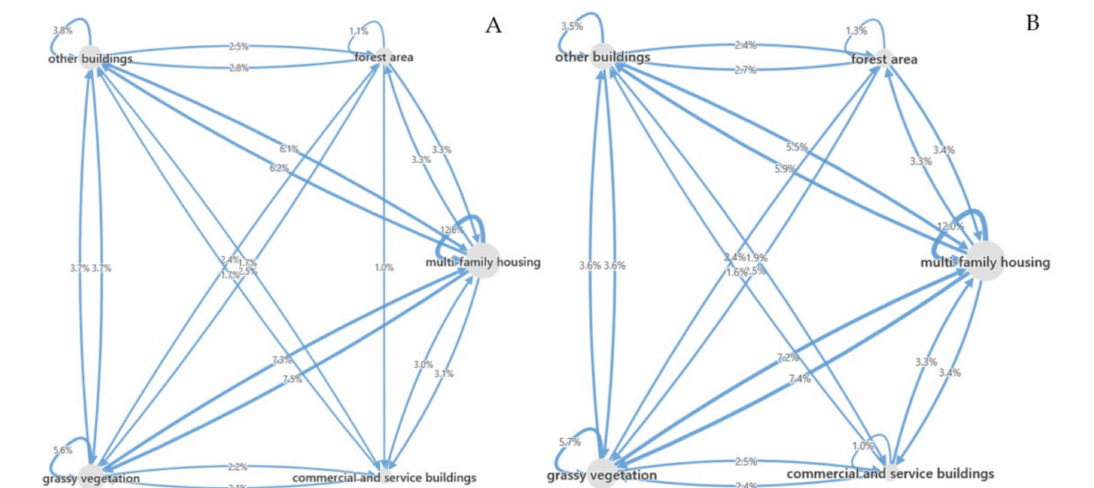
Figure 13. The structure of share of source–destination relationship for ŁPB trips on non-trading ( A ) and trading ( B ) Sundays in Ł ó d´z in 2018 (only relations that constitute at least 1% of all relationships were taken into account). Source: own elaboration based on data from the Ł ó d´z City Hall.